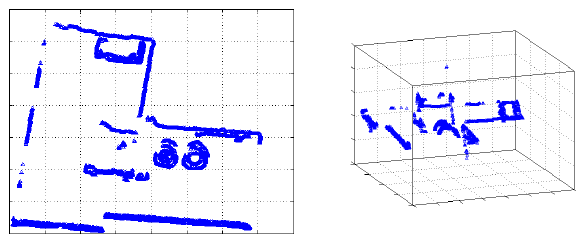
Figure 7. Results of 3D Coordinates by Image Matching